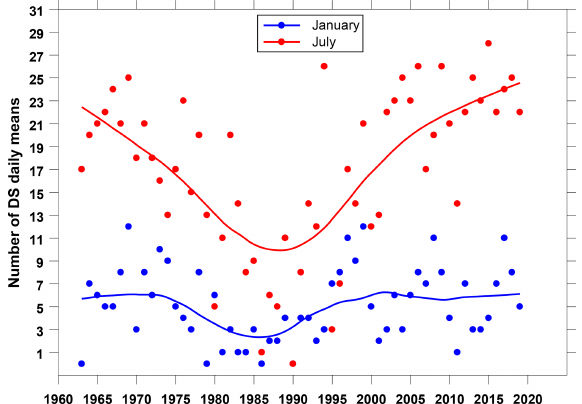
Figure 1. Number of TCO 3 daily means based on the direct sun measurements for January and July in the period